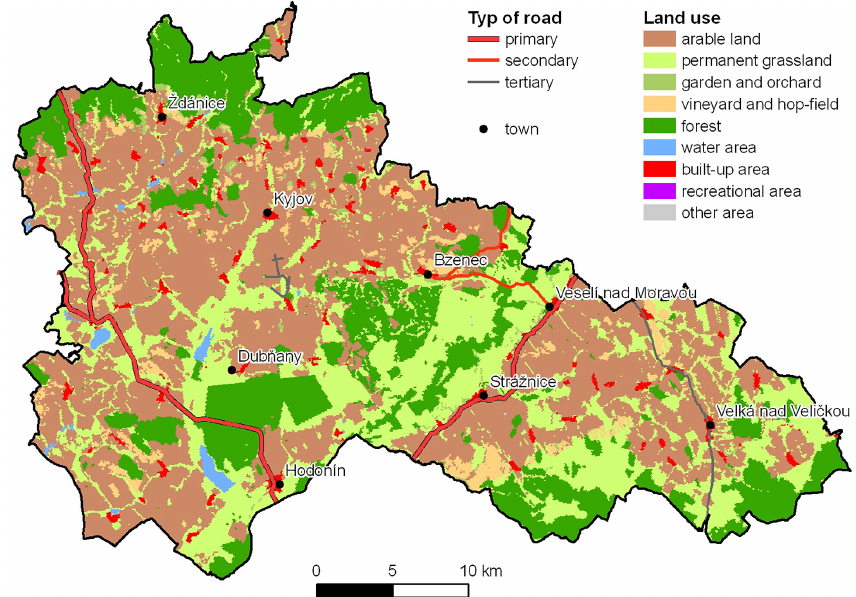
Fig. 5. The road network and land use in the Hodonín region in the